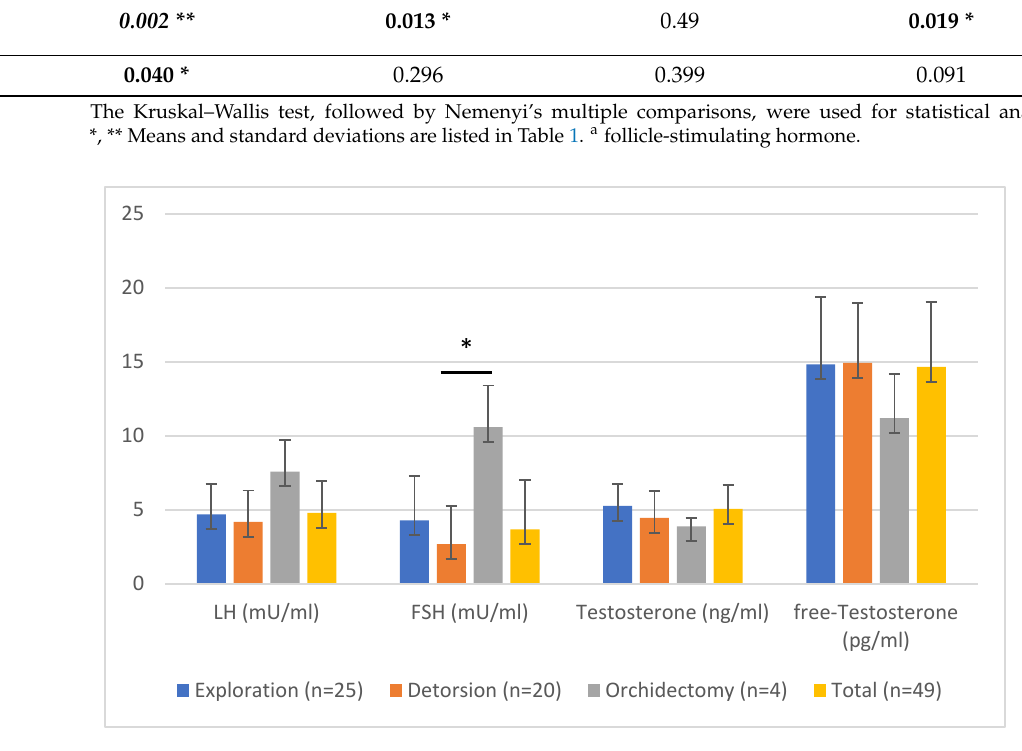
Figure 1. Laboratory parameters at control: LH, testosterone and free testosterone did not differ significantly between groups, whereas FSH was significantly elevated in patients with orchiectomy compared to those who underwent detorsion (* p = 0.005) but not exploration.